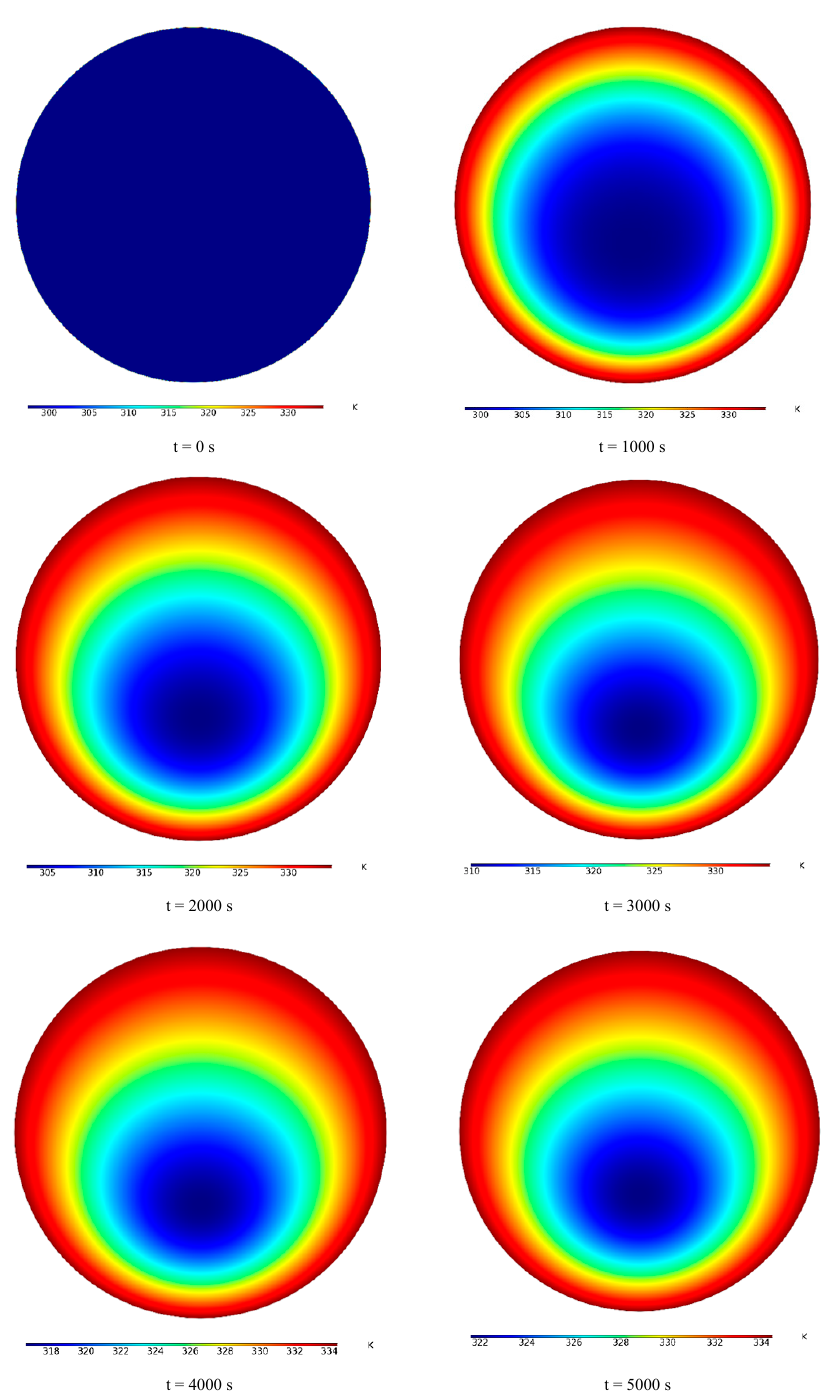
Figure 4. PCM melting contours in a tube filled with PCM from 0 to 5000 s with a time interval of 1000 s. Figure 5 demonstrates the TEM contours of a PCM-filled tube from 0 to 5000 s with a time interval of 1000 s. It is seen that the tube is full of cold PCM, and its TEM is uniformly cold. In this case, all PCM inside the tube is solid. It can be seen that the outer wall is heated due to solar radiation, leading to that the PCM is melted. The hot TEM created in the wall of the tube enters the tube over time and heats all the PCM inside it. Then, more of the tube space is marked by the red-color contour. Additionally, the middle parts of the PCM inside the tube remain solid and not melted over time. In this area, the tube is still cold and the PCM is solid.